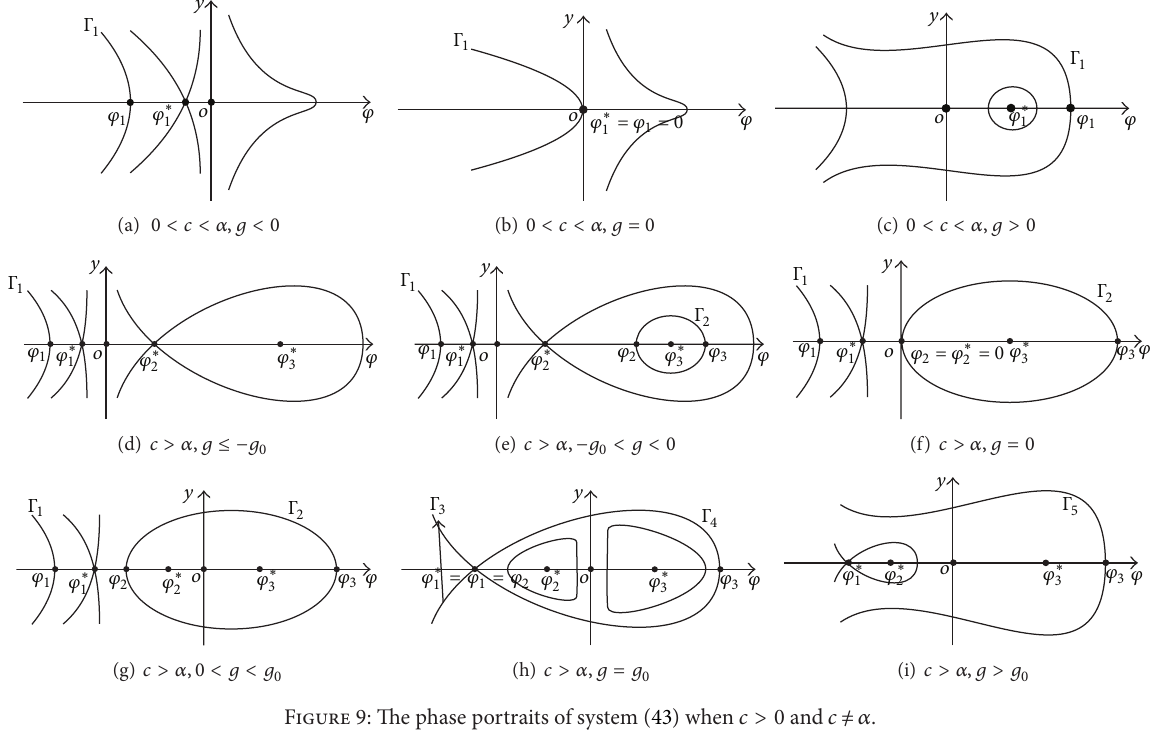
Figure 9: The phase portraits of system (43) when 𝑐 > 0 and 𝑐 ̸=𝛼 .